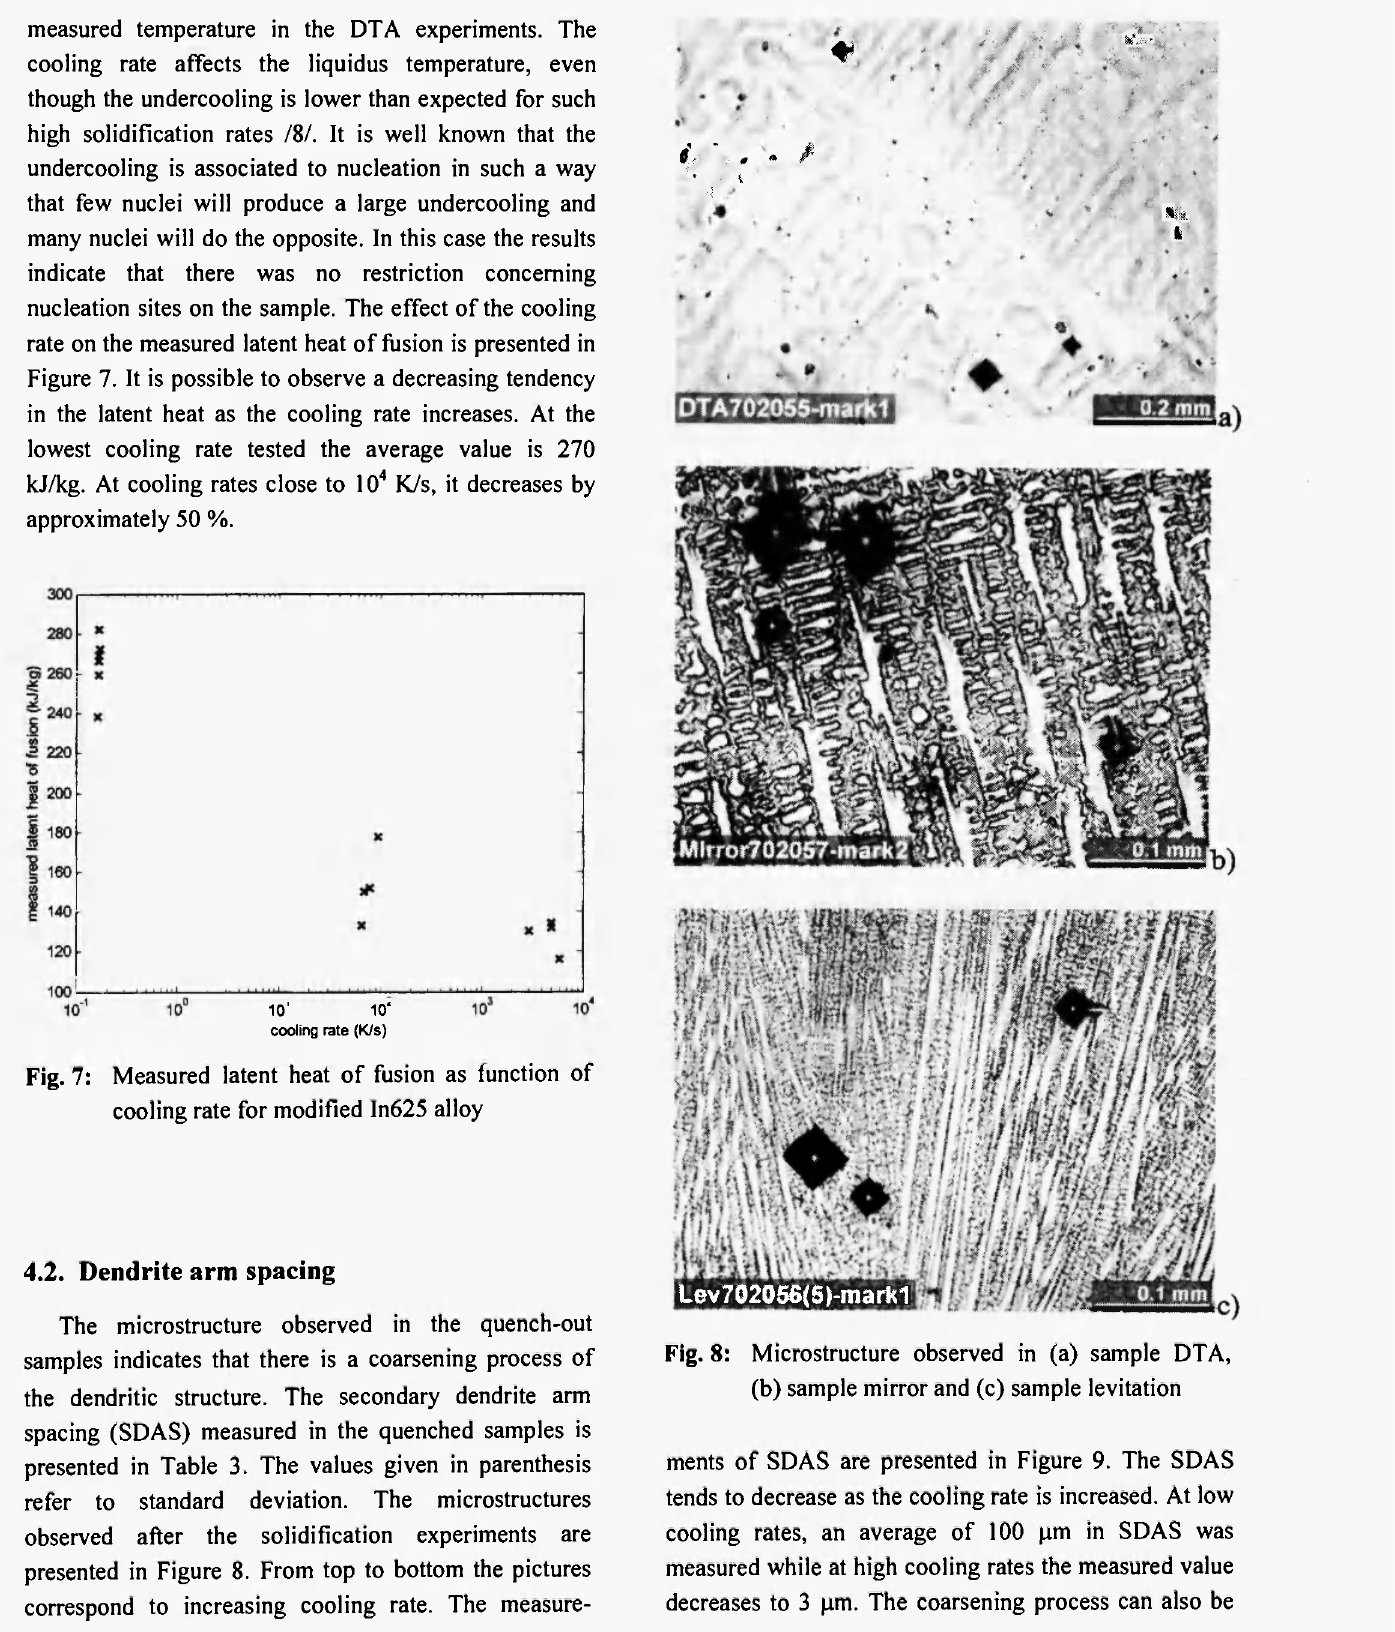
ments of SDAS are presented in Figure 9. The SDAS tends to decrease as the cooling rate is increased. At low cooling rates, an average of 100 μηι in SDAS was measured while at high cooling rates the measured value decreases to 3 μιη. The coarsening process can also